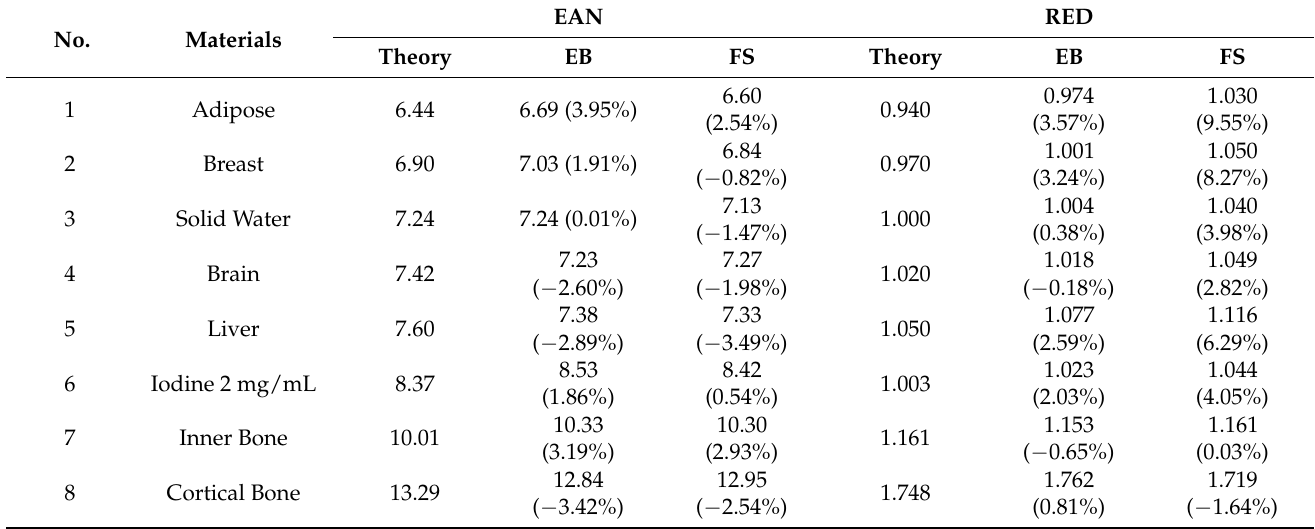
Table 4. Theoretical and experimental values for effective atomic number (EAN) and relative electron density (RED) for eight tissue-equivalent materials. Relative error values are indicated in